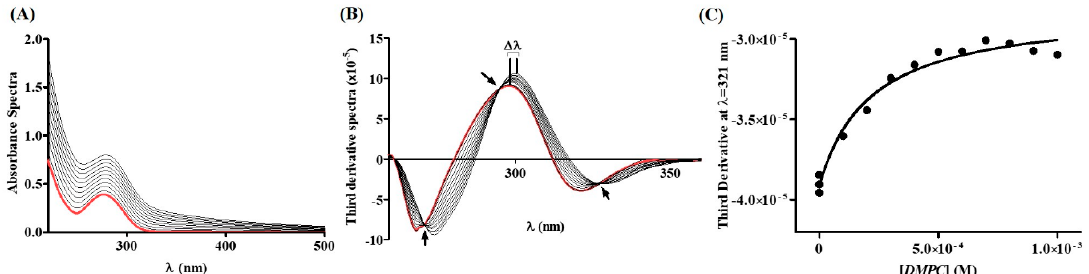
Figure 2. ( A ) DCF (40 µ M) absorption spectra in aqueous buffered phase pH = 5.0 (red spectrum) and after incubation with increasing concentrations of LUVs of DMPC (0–1000 µ M) prepared in the same buffer pH = 5.0 (black spectra); ( B ) third derivative of the absorbance spectra where it is possible to